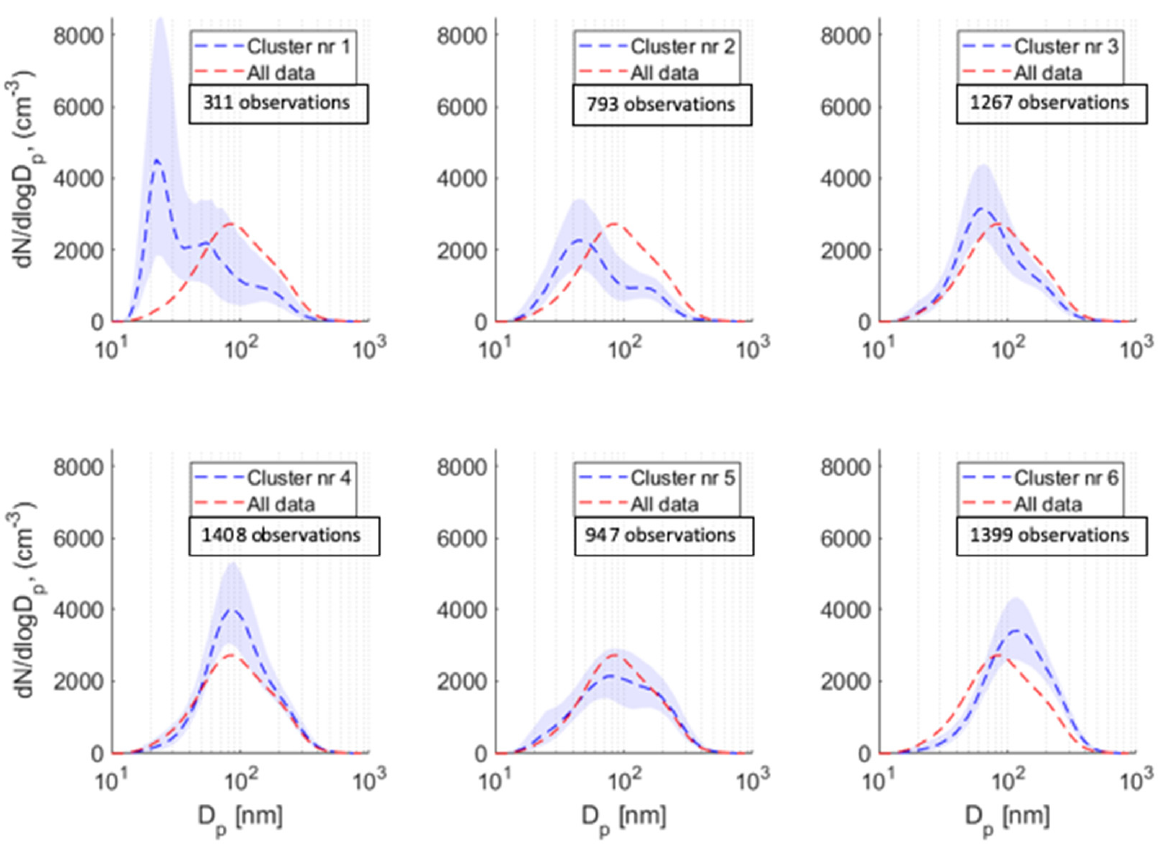
Figure 12. The median of daytime size distribution of cluster 1 to 6 (in blue). The red curve indicate overall median size distribution as reference. The number of members in each cluster is given in the title of each subplot.